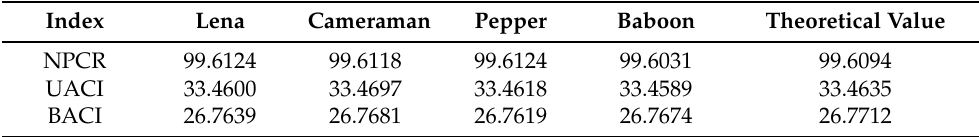
Table 3. The analytical results for the plaintext sensitivity.